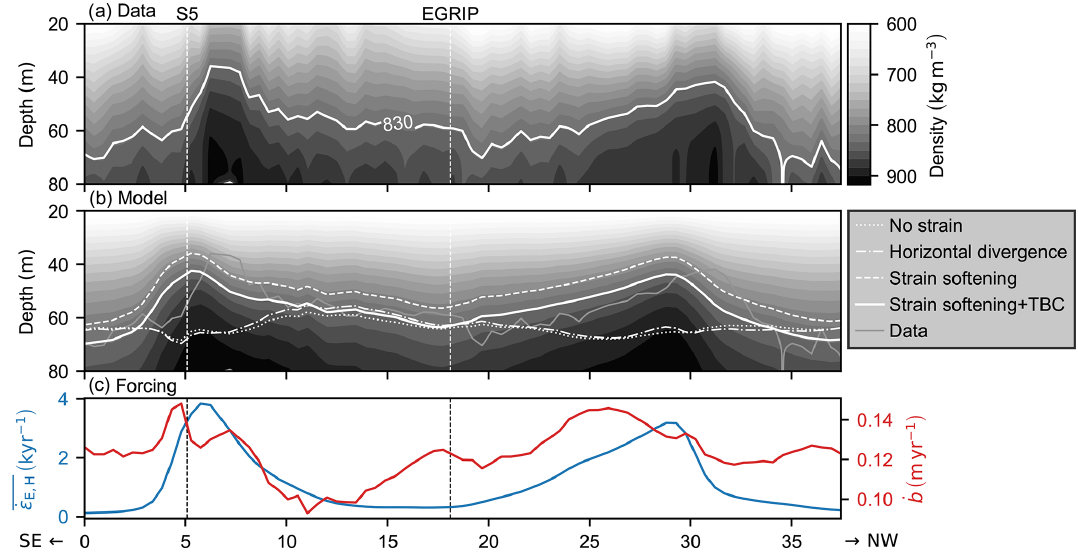
Figure 3. (a) Firn density profile along a cross section of NEGIS recorded by Riverman (2018); Riverman et al. (2019) (Fig. 9b). The white contour line indicates the firn–ice transition. (b) Modeled firn density profile for the same location using the tuning-bias-corrected (TBC) strain softening model, where the white line again indicates the firn–ice transition. The latter is also shown for the cases of no strain, horizontal divergence and the uncorrected strain softening model. (c) Mean effective horizontal strain rate over the firn age and the radar- derived accumulation rate, which are used for forcing the models in (b) . The dashed vertical lines indicate the locations of EGRIP and the S5 shear margin firn core